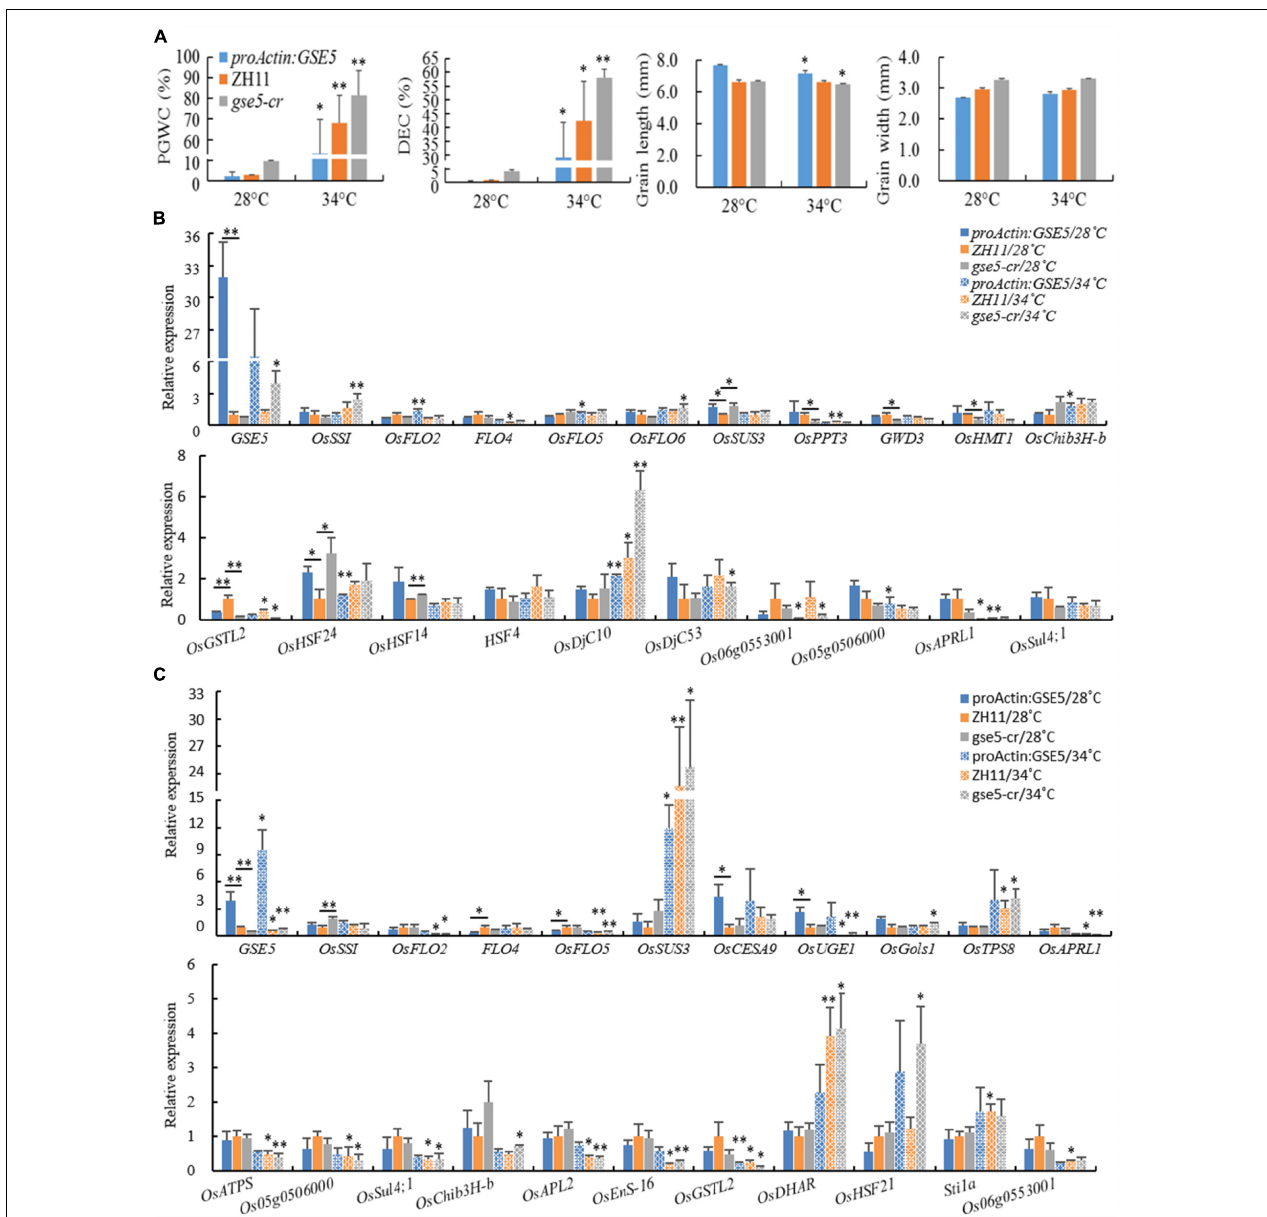
FIGURE 11 | The relative expression levels of some DEGs under heat shock treatment. (A) The chalkiness and grain shape phenotypes of ZH11, proActin:GSE5 and gse5-cr at 28 and 34 ◦ C. ∗ Phenotype differences in a line at different temperatures ( ∗ P < 0.05 and ∗∗ P < 0.01). (B) Some genes showed different expression levels at 6 DAP under heat shock treatment. (C) Some genes showed different expression levels at 12 DAP under heat shock treatment. ∗ with underlining indicates different expression levels between two adjacent lines, ∗ without underlining indicates the different expression levels in a line at different temperatures ( ∗ P < 0.05 and ∗∗ P <